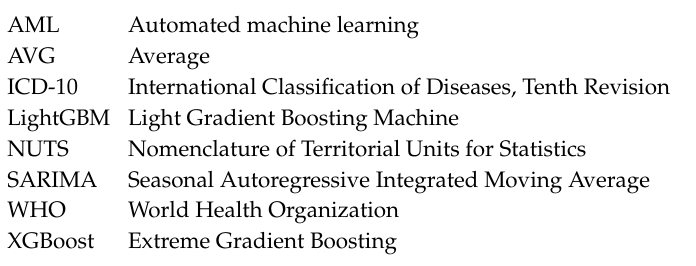
Figure S1: Flow chart of study selection process, Figure S2: Model development workflow process (model blueprint), Figure S3: Schematic representation of model development procedure for lower respiratory infections, Figure S4: Average of hospitalizations due to road injuries on selected public holidays in Romania, Table S1: Listing of ICD-10 codes selected for data extraction and preparation from the whole ICD-10 data set of hospitalized patients in Romania during the period 2008–2018, Table S2: Romanian Public Holidays, Table S3: Exemplary listing of model performances calculated by the AML tool for lower respiratory infections, Table S4: Exemplary summary statistics for lower respiratory infections, Table S5: Comparison of other studies using prediction models on di ff erent